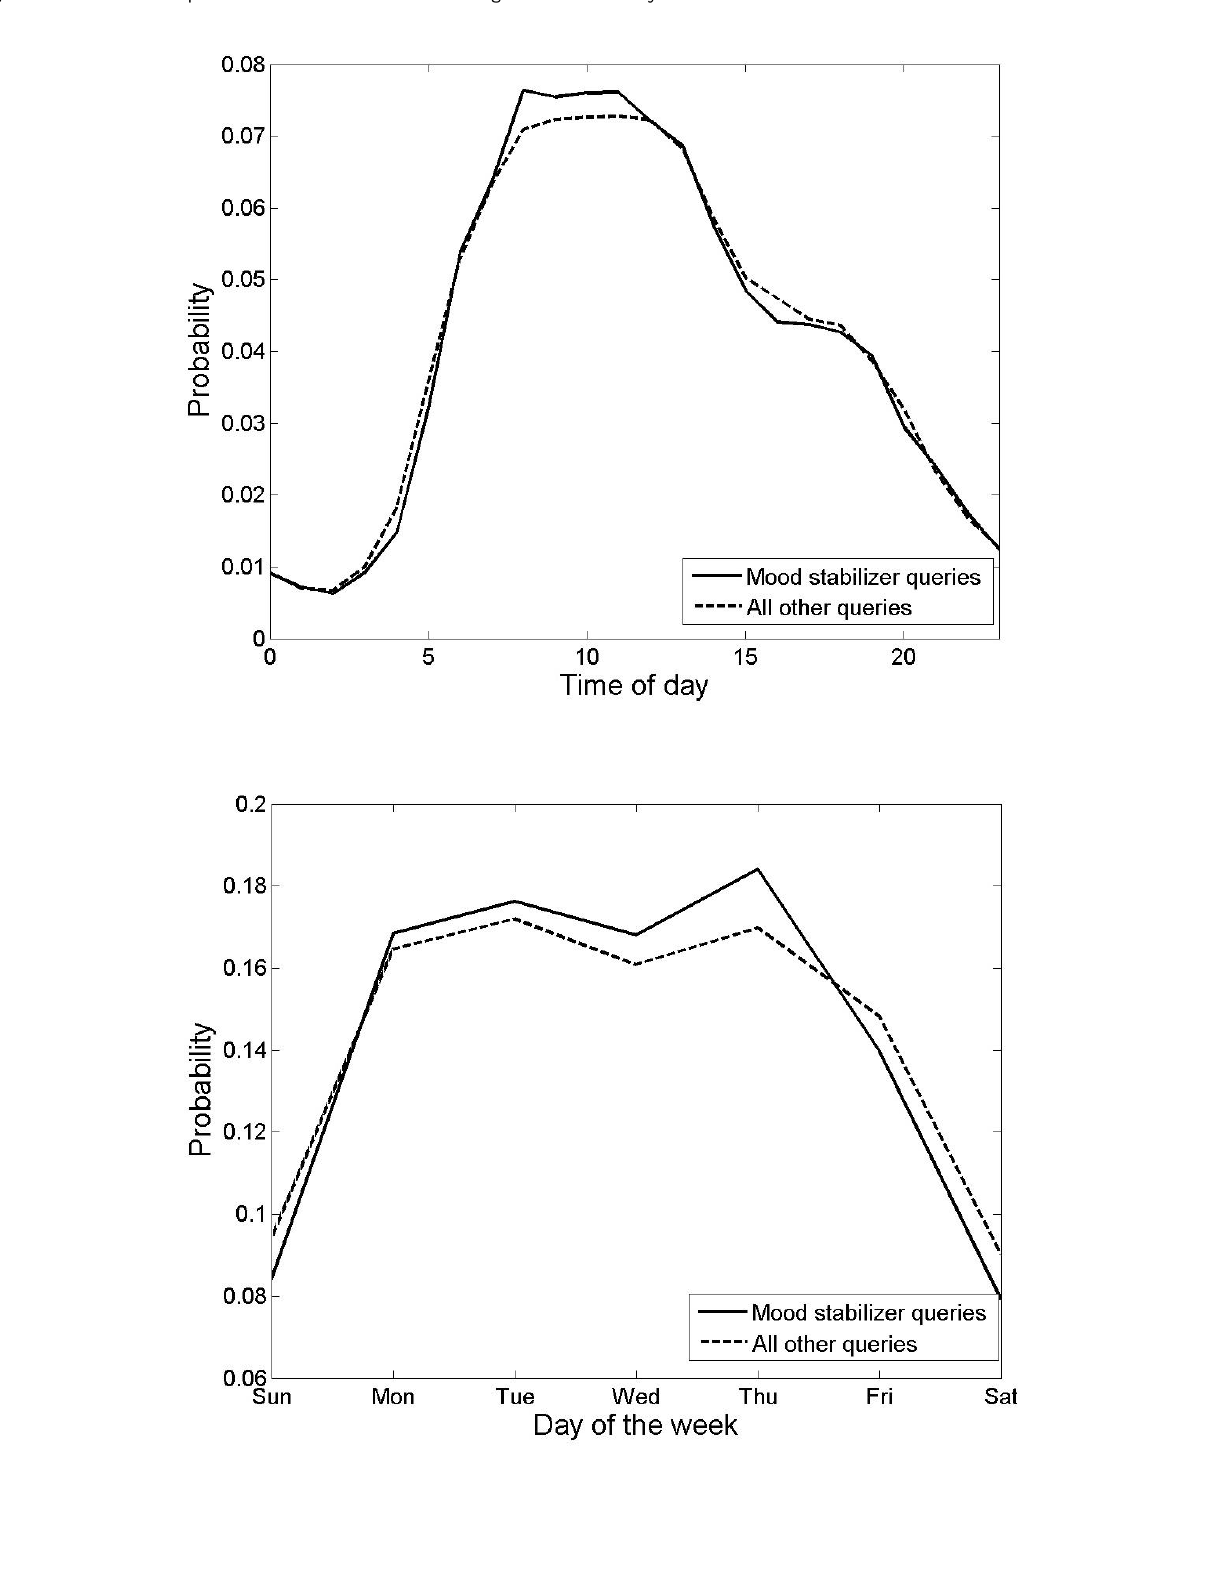
Figure 1. Probability of posting MSD queries as a function of time of day (above) and day of the week (below), compared to all other queries. This figure shows that MSD queries are more common in morning hours of